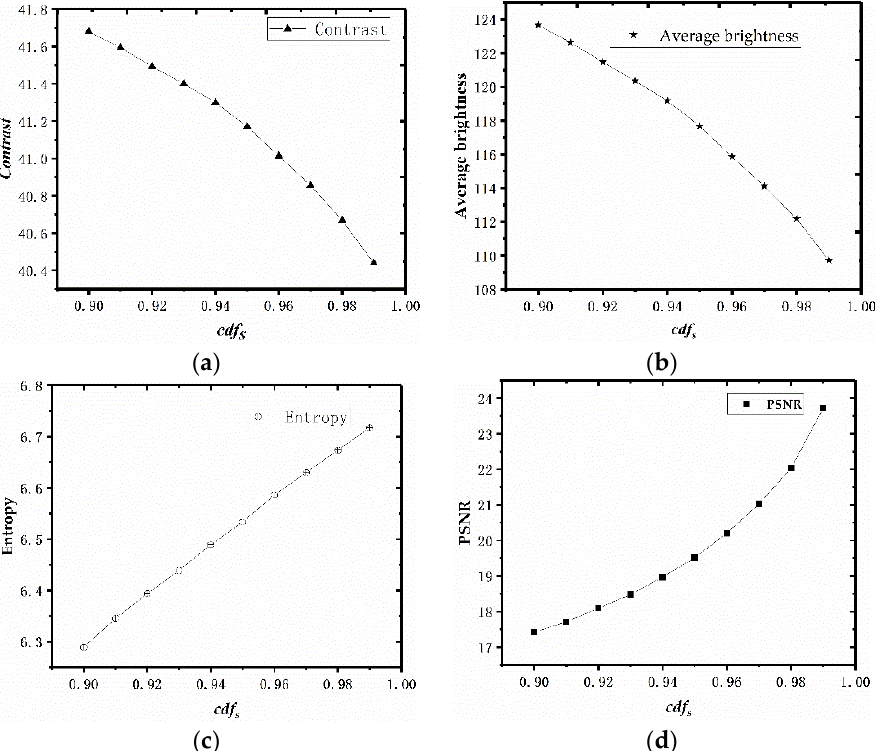
Figure 7. Curves of the effects of cdfs parameters on image performance metrics: ( a ) contrast; ( b ) mean brightness; ( c ) entropy; ( d ) PSNR.